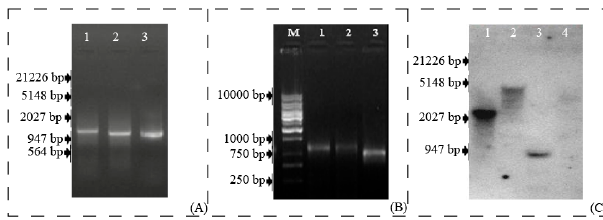
Figure 1. Cloning of Lla CIPK gene: Lla CIPK RACE PCR products of GeneRacer™ primer and gene specific primers. ( A , B ) Electrophoretic analysis of Lla CIPK 5 ′ RACE PCR products & 3 ′ RACE PCR products respectively. Lane M-DNA Marker & 1, 2, 3 are RACE amplified fragments. ( C ) Autoradiogram of Southern blot of Lla CIPK. Genomic DNA (20 μ g) was digested with four different